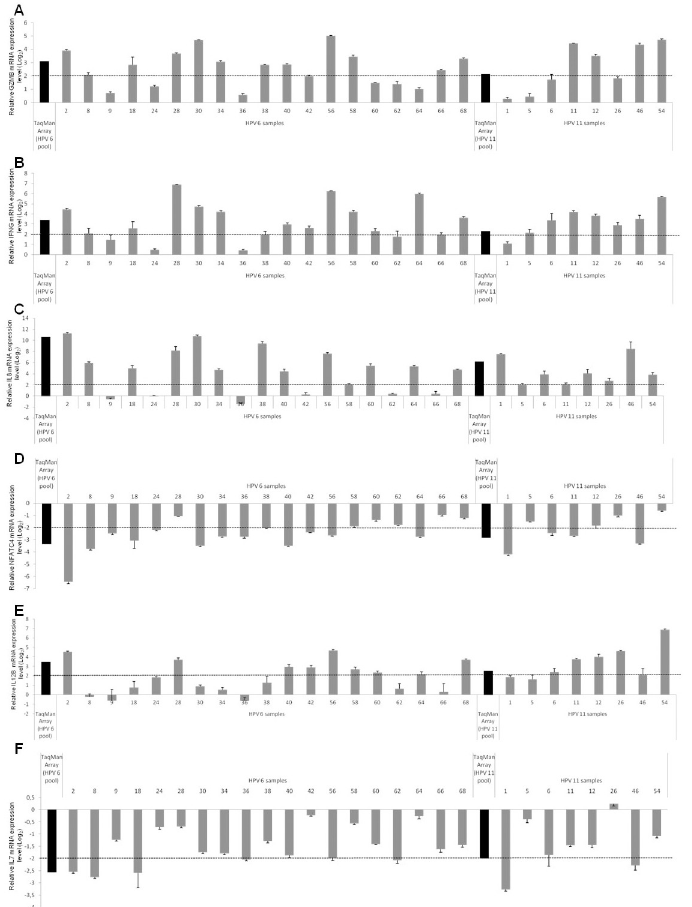
Fig 2. A–F: Validation using RT-qPCR of immune-related genes that were differentially expressed in condyloma acuminata. The expression of GZMB (A), IFNG (B), IL8 (C), NFATC4 (D), IL12B (E), and IL7 (F) in condyloma samples (HPV6 positive and HPV 11 positive) compared to that in the control (HPV negative samples) is shown as fold change (log2) relative to expression.